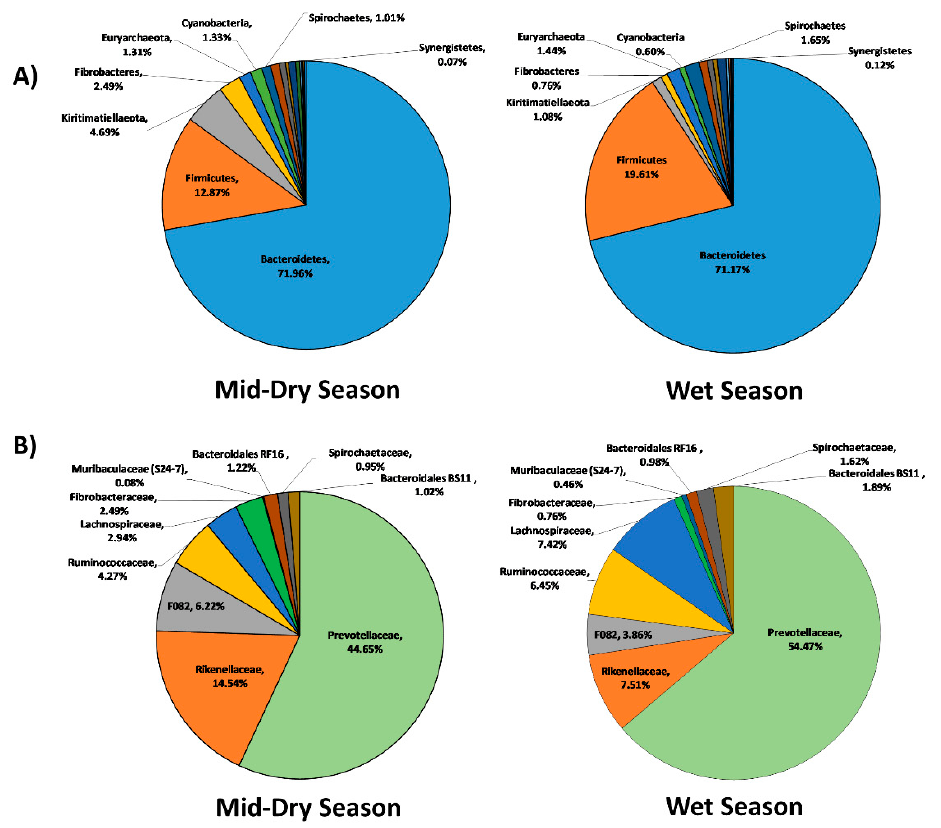
Figure 2. Taxonomic composition of the rumen bacteria community at the phylum level ( A ) and family level ( B ) for the mid-dry and wet seasons in un-supplemented animals.